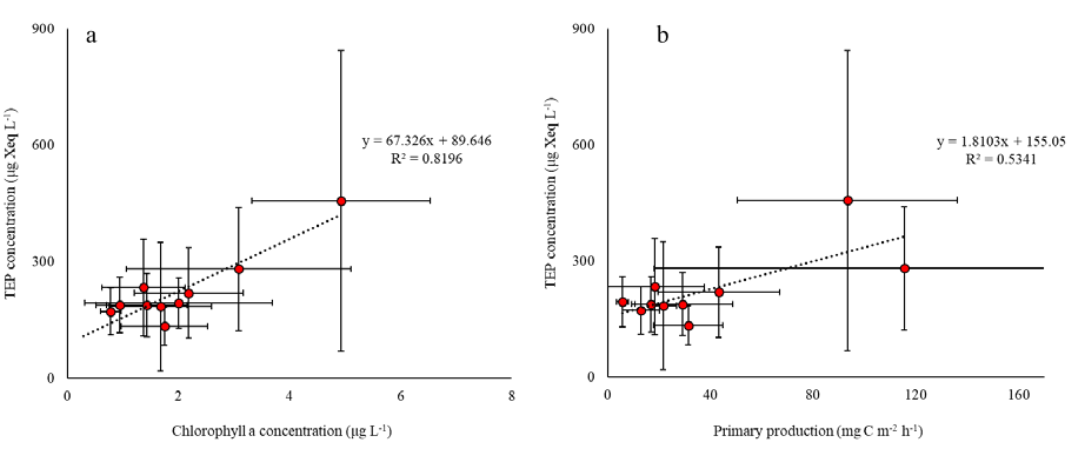
Figure 4. Lag-phased correlations between ( a ) chlorophyll a and TEP concentration and ( b ) primary production and TEP concentration. Table 4. Comparison of the TEP-C contribution to the POC (%) between this and previous studies. Region Season TEP-C / POC